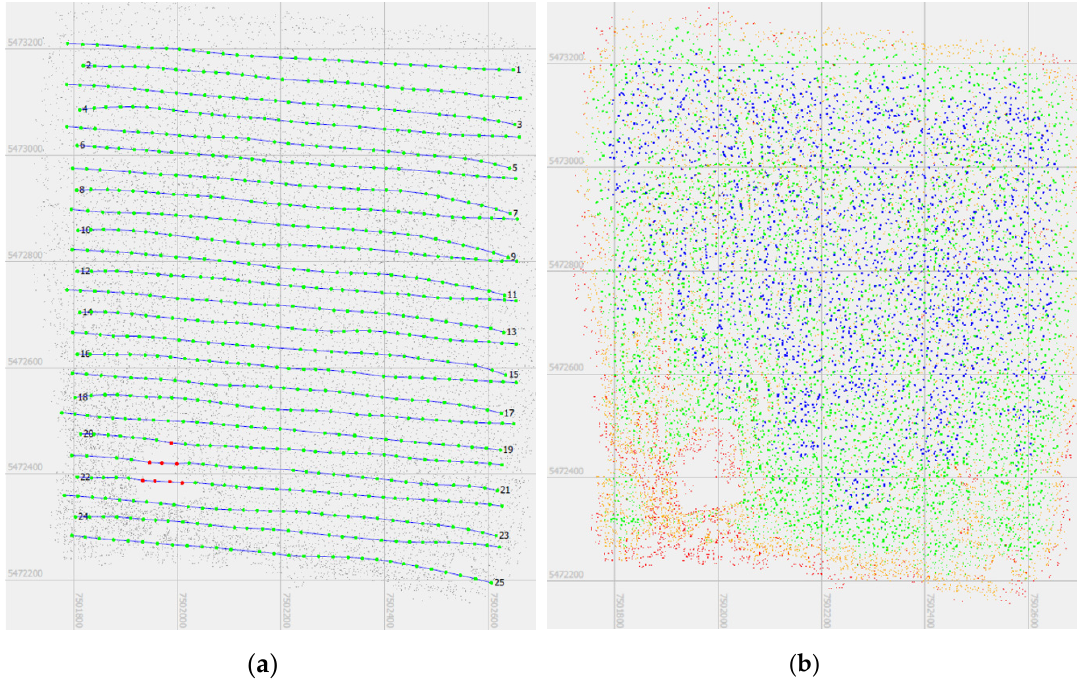
Figure A1. ( a ) Flight path. ( b ) Tie points distribution; PL-2000 coordinate system (EPSG: 2178).